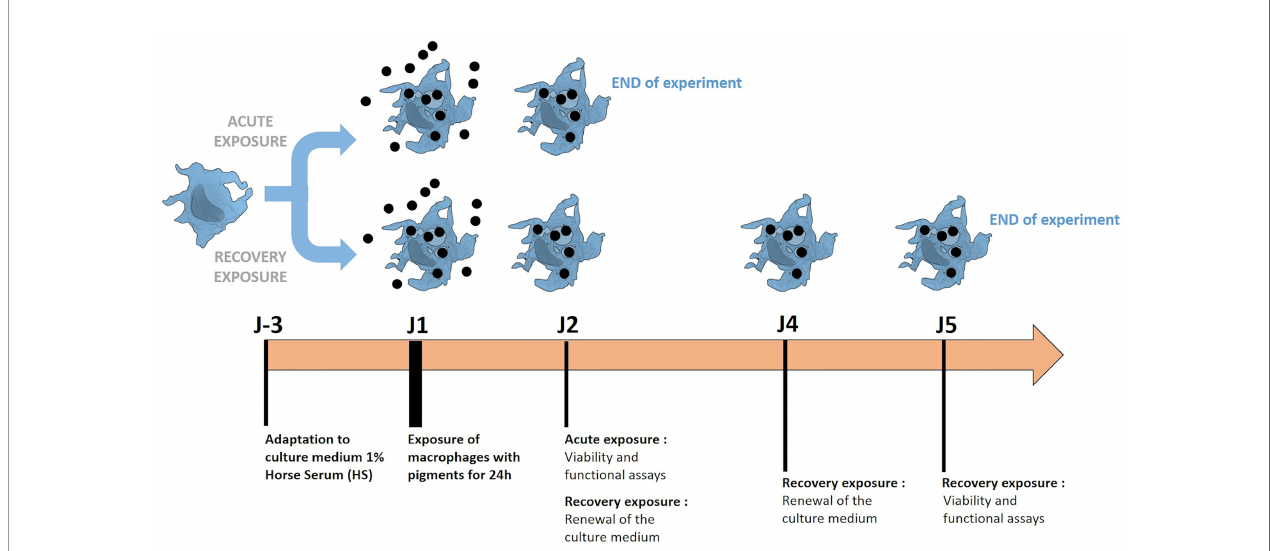
FIGURE 1 | Schematic representation of experiments using macrophages exposed with pigments. The methodology of acute exposure and recovery was illustrated. Cells are grown in a low serum culture medium (1% horse serum), to which they are fi rst adapted. The exposure and recovery phases are then performed to analyze the induced